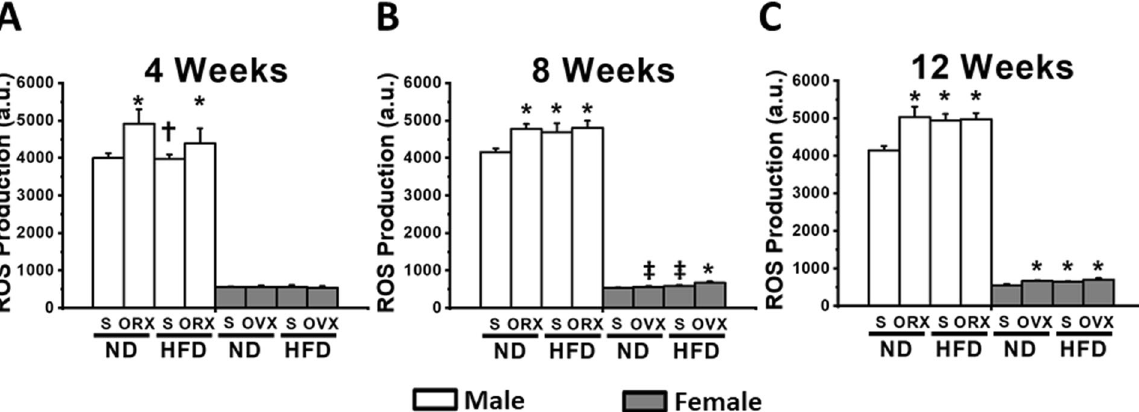
Fig. 3 The effect of sex hormone and dietary consumption on cardiac mitochondrial ROS level at different time courses (4, 8, and 12 weeks). A The cardiac mitochondrial ROS level at 4 weeks. B The cardiac mitochondrial ROS level at 8 weeks. C The cardiac mitochondrial ROS level at 12 weeks. * P < 0.05 vs sex-matched ND-Sham ( n = 6/group). * P < 0.05 vs sex-matched ND-Sham ( n = 6/group). † P < 0.05 vs male orchiectomized rats ( n = 6/group). ‡ P < 0.05 vs female high-fat diet-fed ovariectomized rats ( n = 6/group). S sham, ND normal diet, HFD high- fat diet, ORX orchiectomized rats, OVX ovariectomized